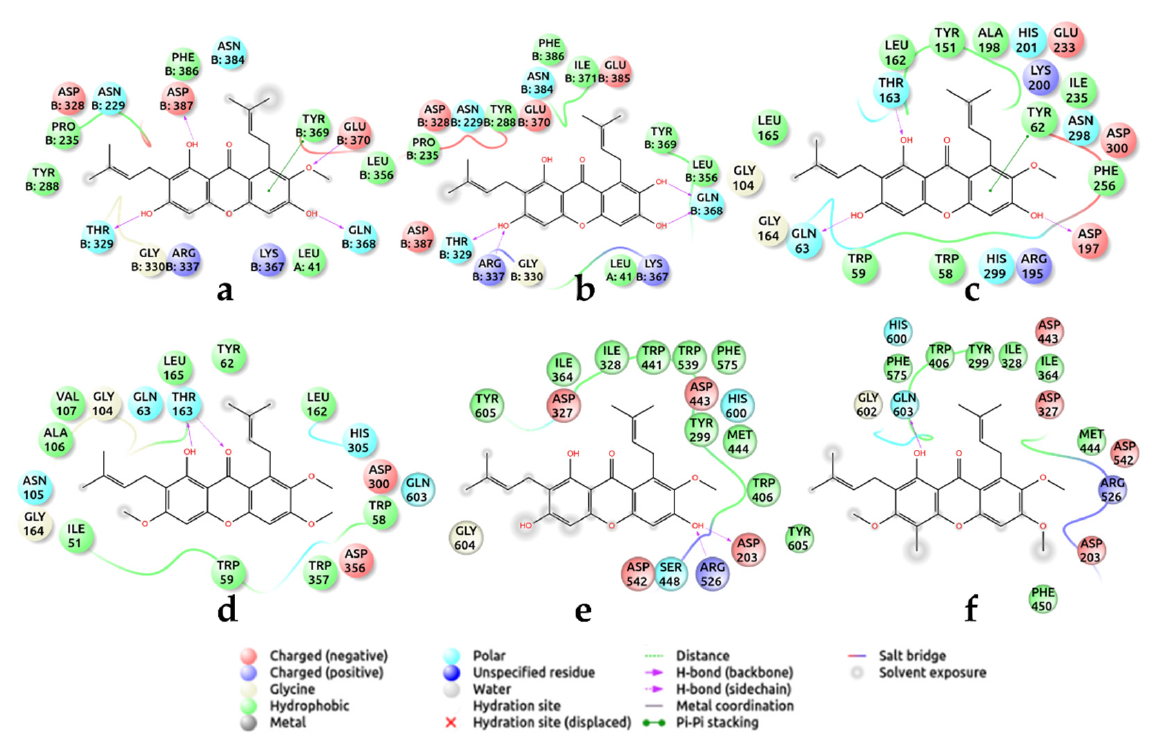
Figure 3. Top-scoring binding poses complex PL (( a )— 4 , ( b )— 5 ), AA (( c )— 4 , ( d )— 6 ), AG (( e )— 4 , ( f )— 11 ).